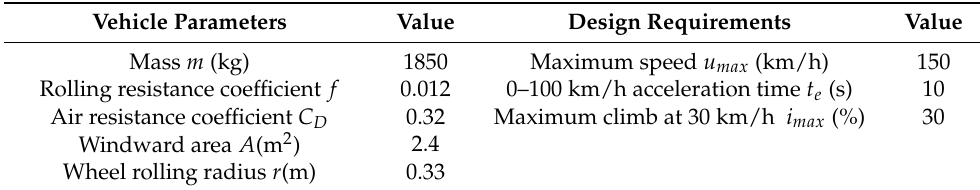
Table 1. Vehicle parameters and design